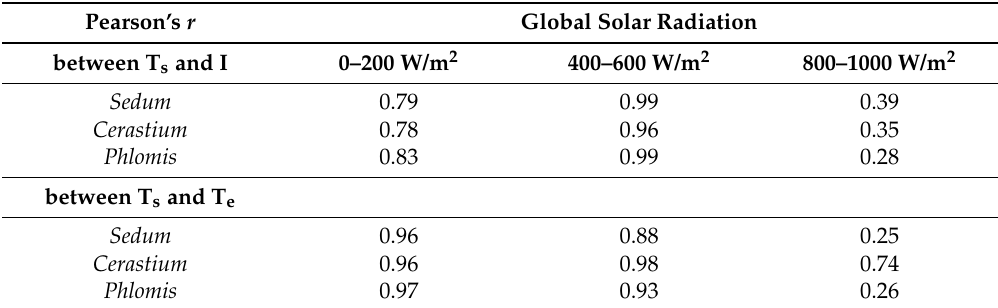
Table 2. The Pearson product-moment correlation coefficient between (T s ) and (I), and between (T s ) and (T e ), calculated considering three global solar radiation intervals.